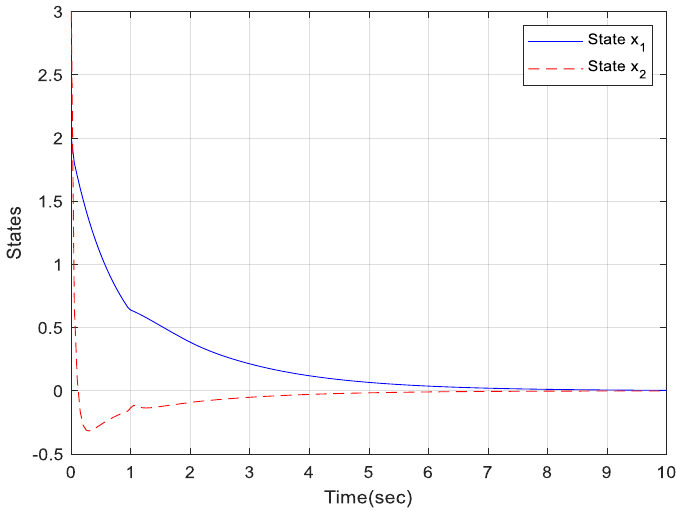
Figure 5. Trajectories for 𝑥 1 and 𝑥 2 .